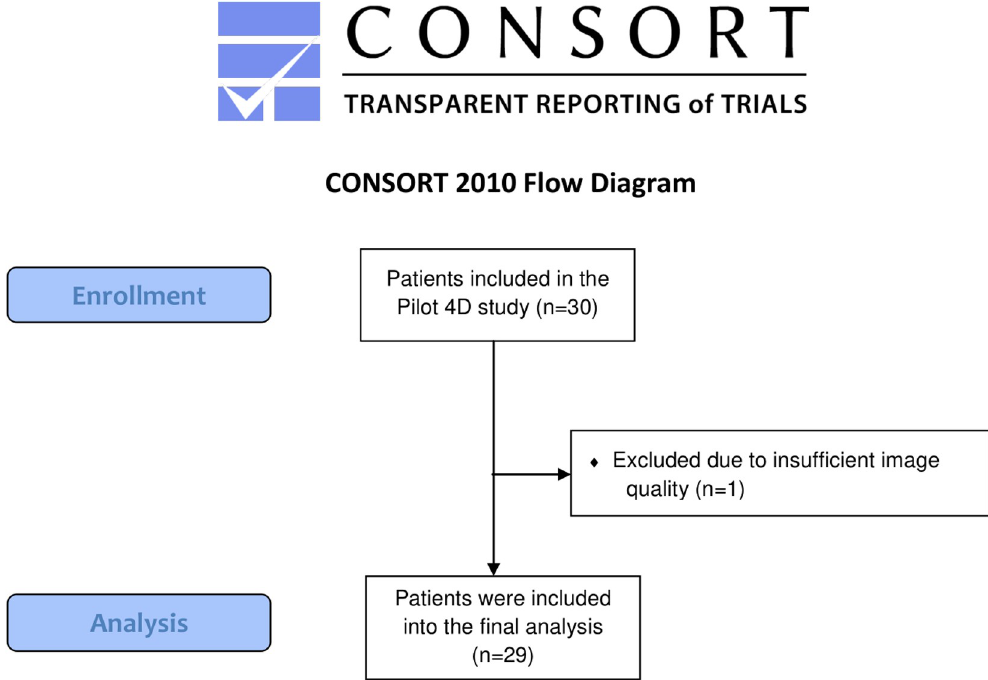
Fig 1. CONSORT flow diagramme. Flow diagramme of the 4D CTP Pilot Image Quality sub-study. Thirty patients were eligible and included in the pilot study. Because of the intra-individual study design, this flow chart does not include a randomisation process. See the main study for further details with regard to inclusion and exclusion criteria, patient recruitment and follow-up (Feger et al. IJCVI 2016). One patient was excluded from the final analysis due to insufficient general image quality of CTA and CTP, leaving 29 patients for the final